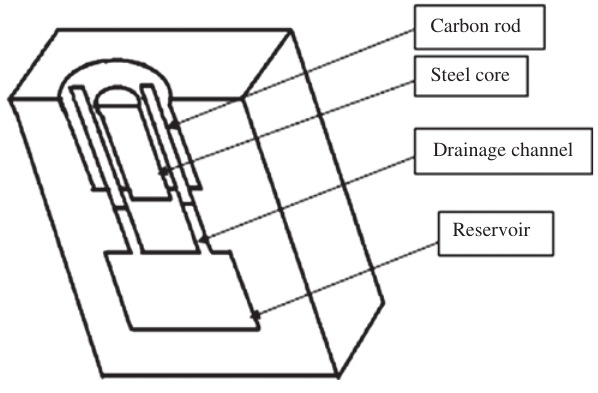
Figure 16: Schematic of the internal decanting process apparatus.